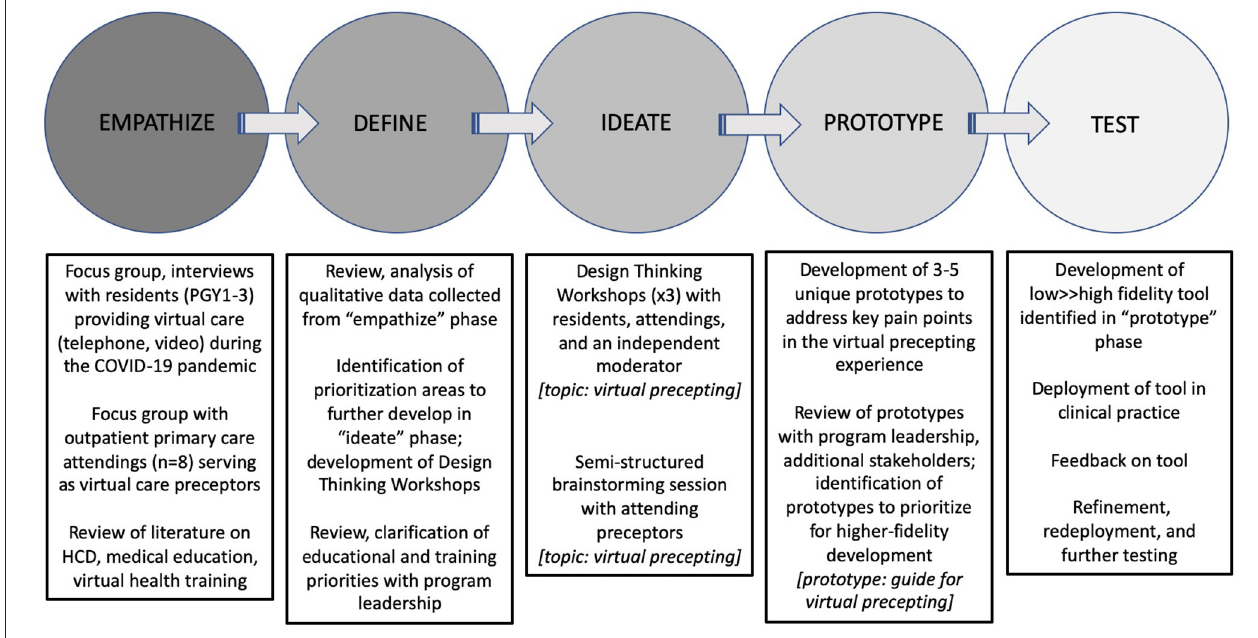
FIGURE 1 | The Design Thinking